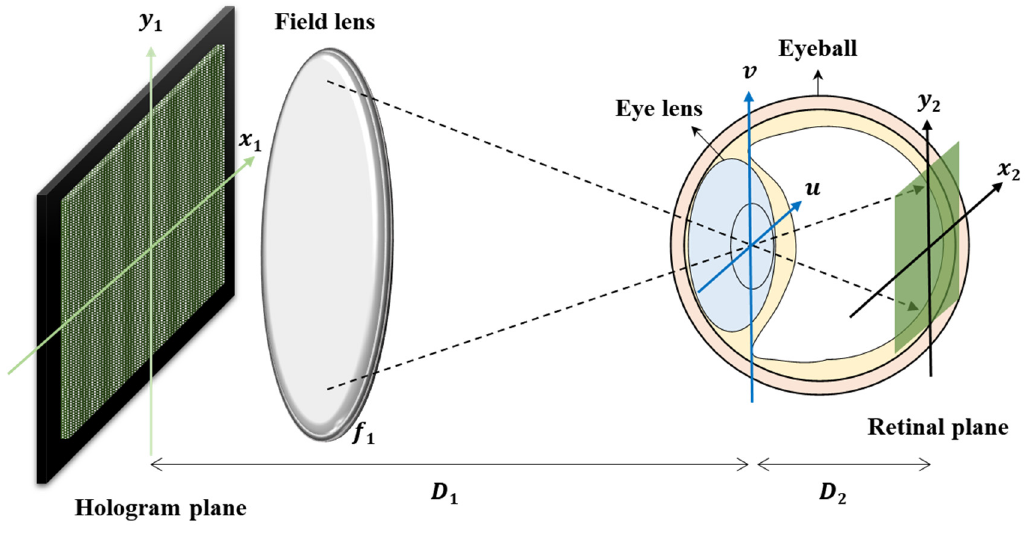
Figure 4. Geometry of the optical system for each eye in the near-eye holographic 3D display. The eye of the observer lens on the u - v coordinate is located at the position of the focal length of the field lens, corresponding to the center of the Fourier plane of the holographic display.